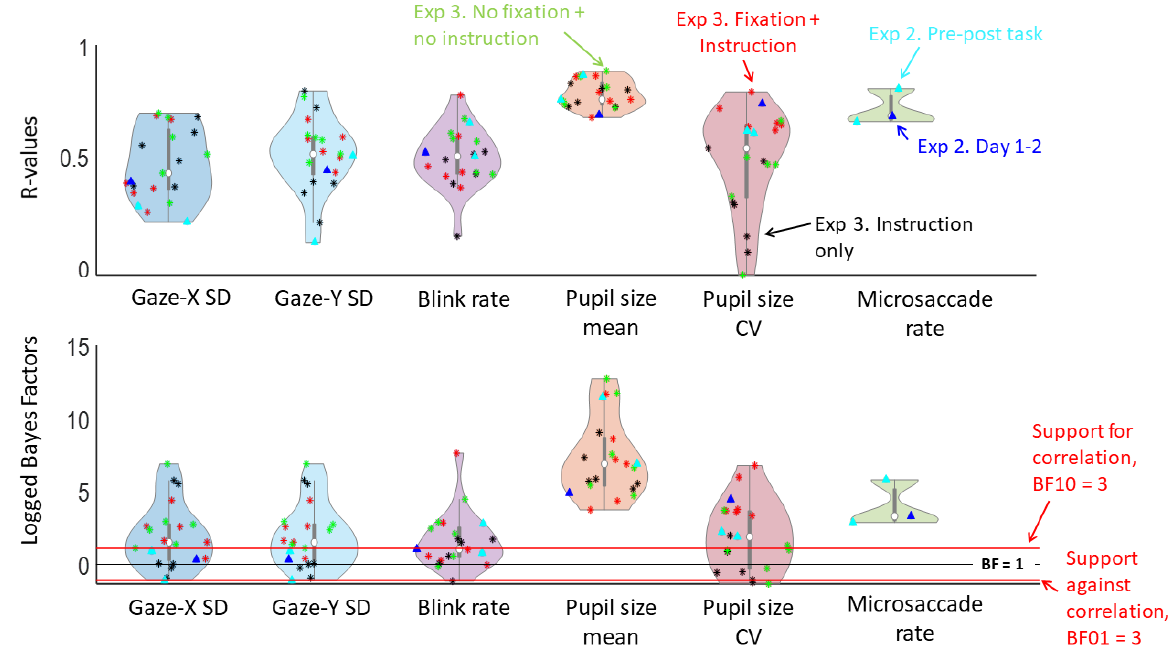
Figure 4. Distributions of the correlation coefficients (top panel) and accompanying logged Bayes Factors (bottom panel) of the correlation analyses on within-subject reliability for each of the five oculomotor measures. Values denoted with a triangle represent the correlations for Experiment 2, with light-blue triangles representing the correlations between different time points (pre and post task), and dark-blue triangles representing the correlation between days. Values denoted with an asterisk represent the correlations for Experiment 3, with red, black, and green representing the different conditions (‘Fixation plus instruction’, ‘No fixation, instruc- tion only’, and ‘No fixation plus no instruction’ respectively). In the top panel, higher values on the y-axis indicate higher correlation coefficients. In the bottom panel, values above the upper red line indicate evidence in favour of the existence of correlations over time, while values below the lower red line (log(BF) < -1) indicate evidence against correlation over time. Values falling between the two red lines are interpreted as indeterminate. Overall, reliability seems low for variability in gaze position, particularly in the hori- zontal dimension, but the other measures show good